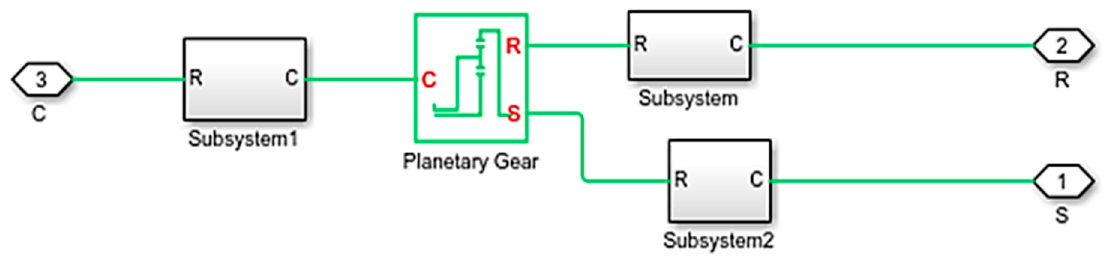
Figure 7. Planetary gear train.